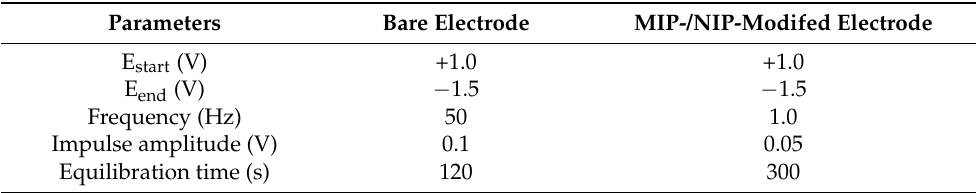
Table 1. Experimental conditions, optimized through a Design of Experiments (DoE) approach, for Irbesartan analyses by